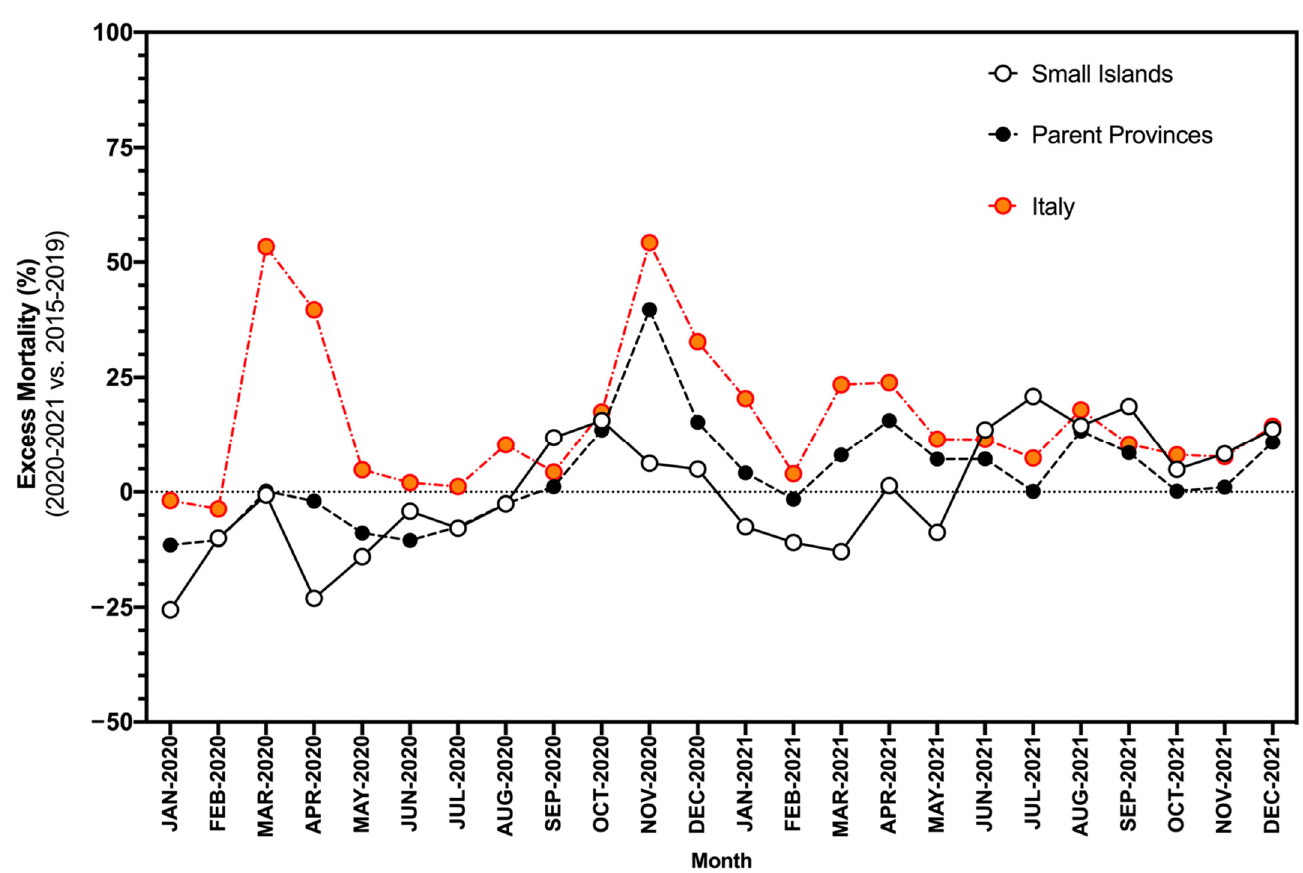
Figure 5. Excess mortality on Italian small islands compared to parent provinces and national estimates for the time period January 2020–December 2021. In the calculations, average monthly mortality rates for 2015–2019 were retained as references.